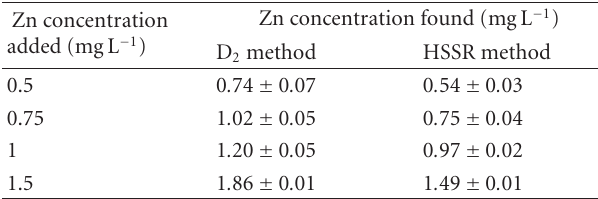
Table 7: Determination of traces of Zn in 2% Fe solution by direct aspiration-FAAS using the D 2 and the HSSR